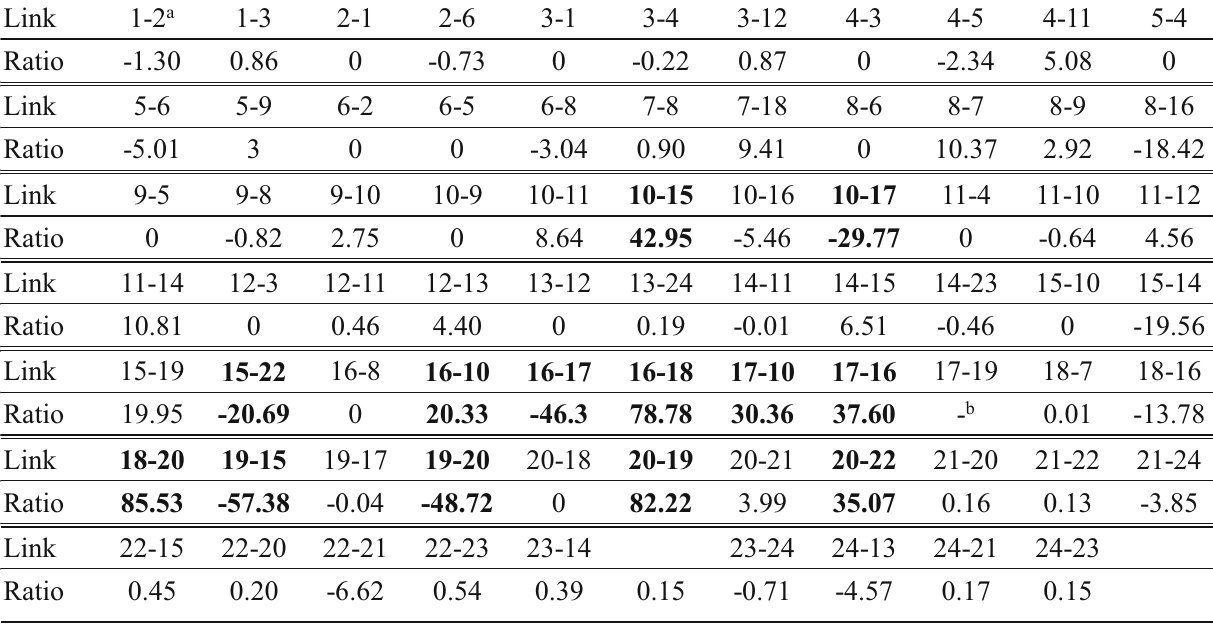
Table 5 Relative change ratio of link flows after closing link 17–19 (%)